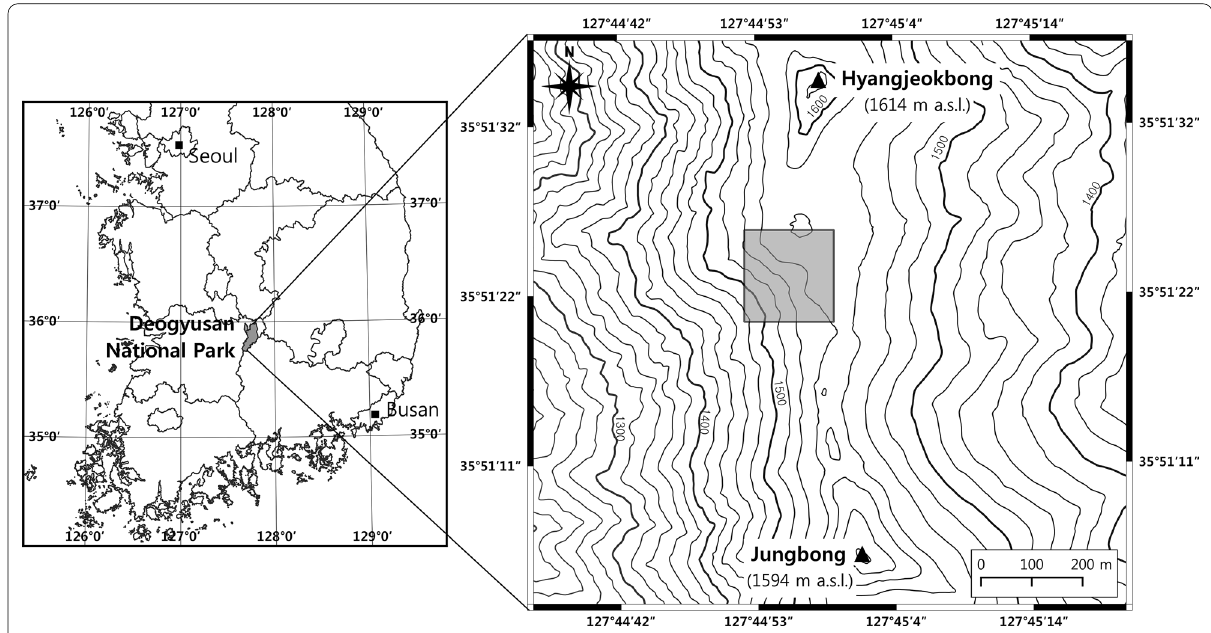
Fig. 1 Location of Deogyusan National park and sampling site (grey box)